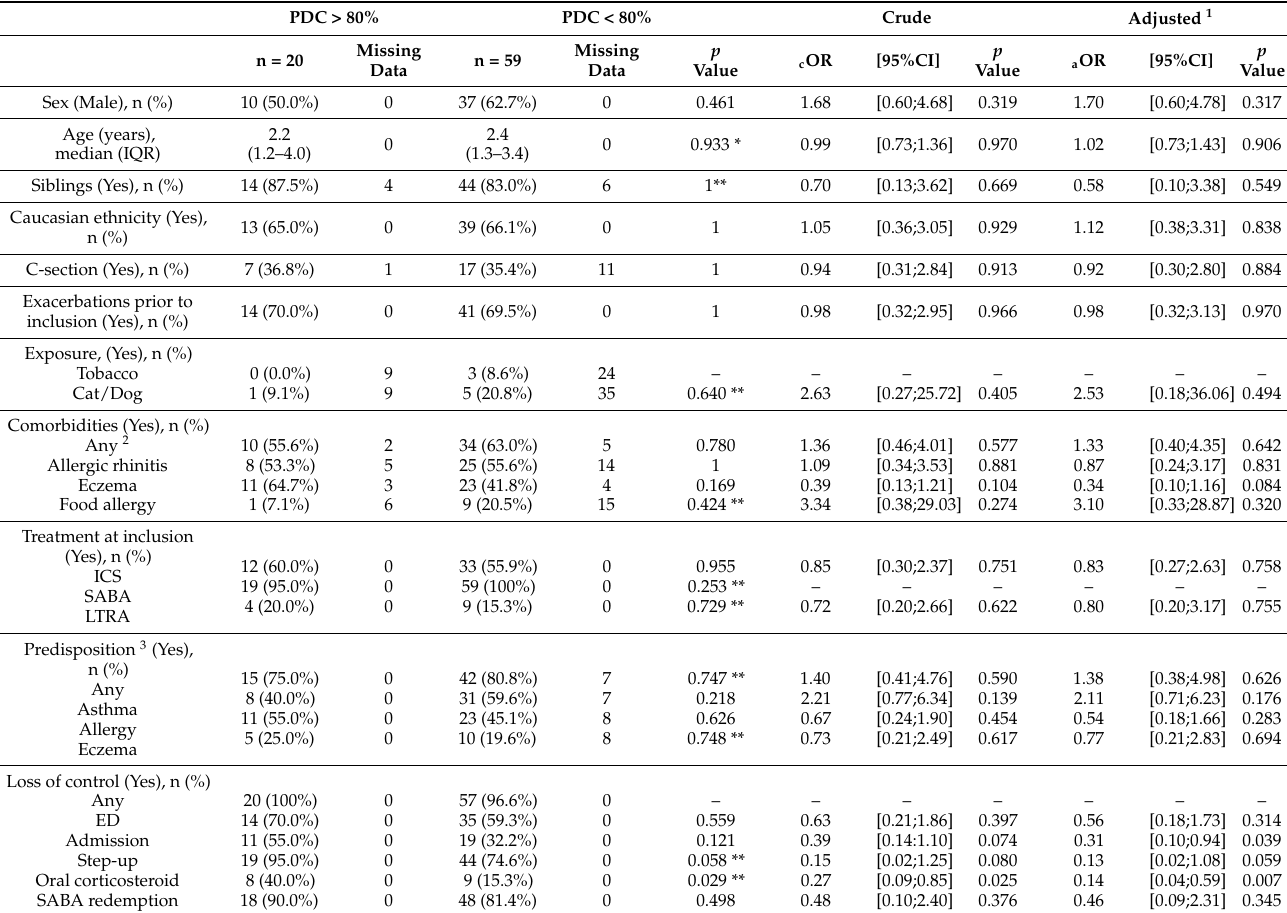
Table 2. Risk factors related to non-adherence (PDC <